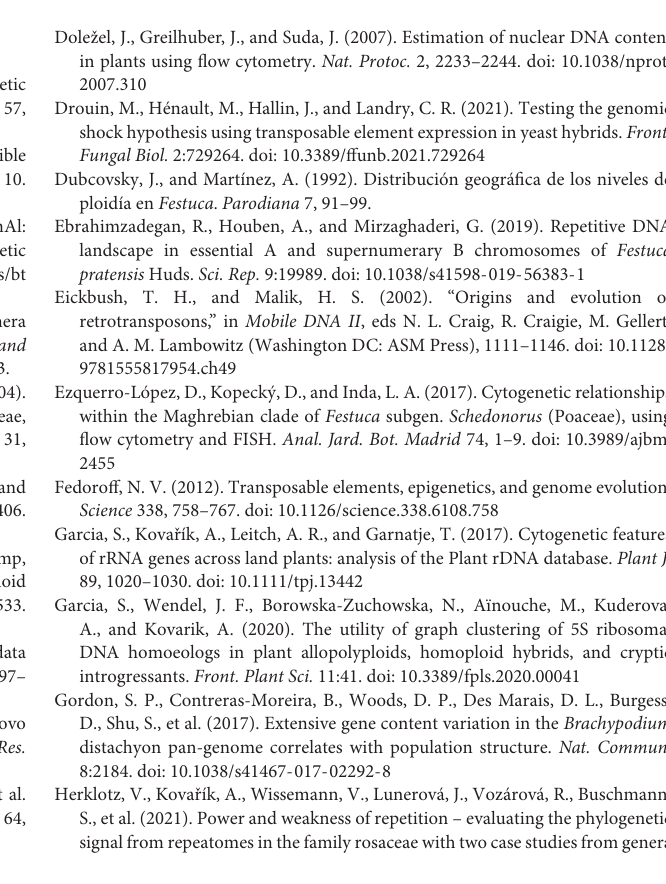
Supplementary Figure 2 | Correlation plots of repeat content and genome size variation (1Cx) for the 23 Loliinae taxa with known genome sizes. Individual plots for the most represented repeat types found across the 23 Loliinae taxa with known genome size data (see Table 2 and Figure 2 ). Color codes of Loliinae lineages correspond to those indicated in Figure 1 . Supplementary Figure 3 | Evolutionary networks based on standardized repeat data sets obtained from the comparative RE2 analysis of the four Loliinae evolutionary groups: (A) Loliinae, (B) broad-leaved (BL) Loliinae, (C) fine-leaved (FL) Loliinae, (D) Schedonorus. The networks were constructed from distance-based NJ trees computed with pairwise inverse distances between samples (see text). Color codes of Loliinae lineages are indicated in the respective charts. Scale bar: number of mutations per site. among the studied samples in each of the four evolutionary groups of Loliinae and phyloheatmaps of normalized values for different sets of repeat clusters retrieved by RE2 from the comparative analysis of each group: (A) Loliinae (38 samples, 38 clusters), (B) broad-leaved (BL) Loliinae (15 samples, 96 clusters), (C) fine-leaved (FL) Loliinae (17 samples, 122 clusters), (D) Schedonorus (16 samples, 167 clusters). Repeat clusters showing significant phylogenetic signal are highlighted with dotted lines. Supplementary Figure 5 | Maximum Likelihood nuclear 5S rDNA cistron tree showing the relationships among the 47 studied Loliinae samples. Ultrafast bootstrap support values are indicated on branches. Oryza eichingeri and Brachypodium distachyon outgroups were used to root the tree. Color codes of Loliinae lineages are indicated in the chart. Scale bar: number of mutations per